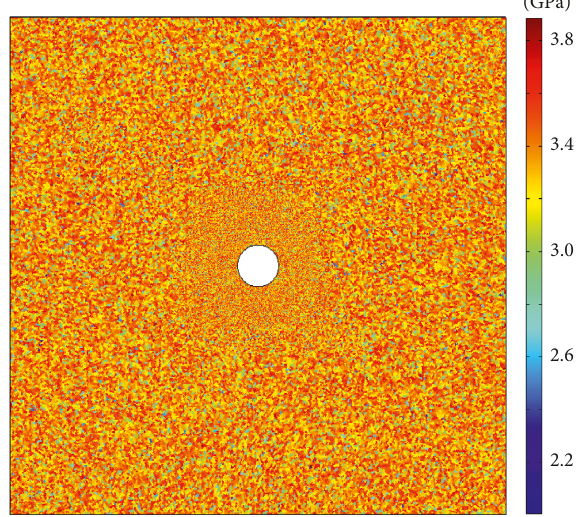
Figure 7: Distribution diagram of initial elastic modulus ( m �